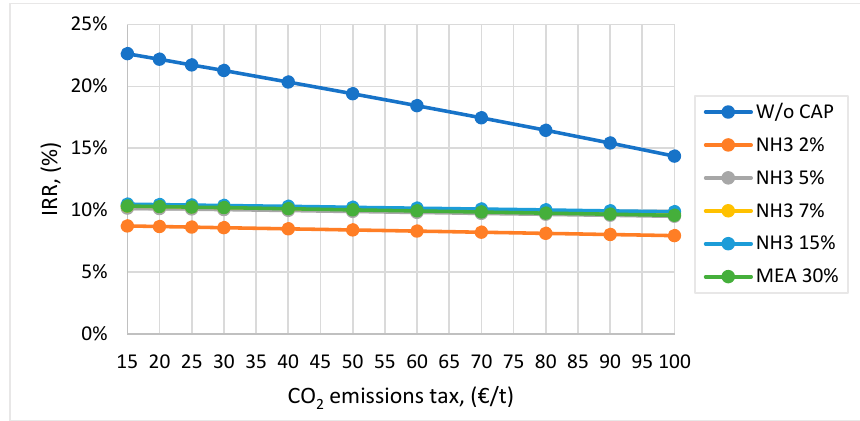
Figure 5. NPV with and without the CO 2 capture process according to the CO 2 emissions tax.